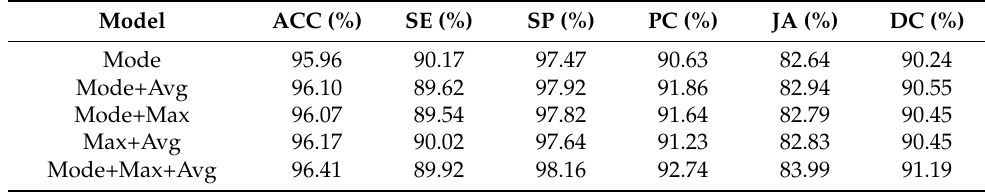
Table 3. Ablation experiment on AMB